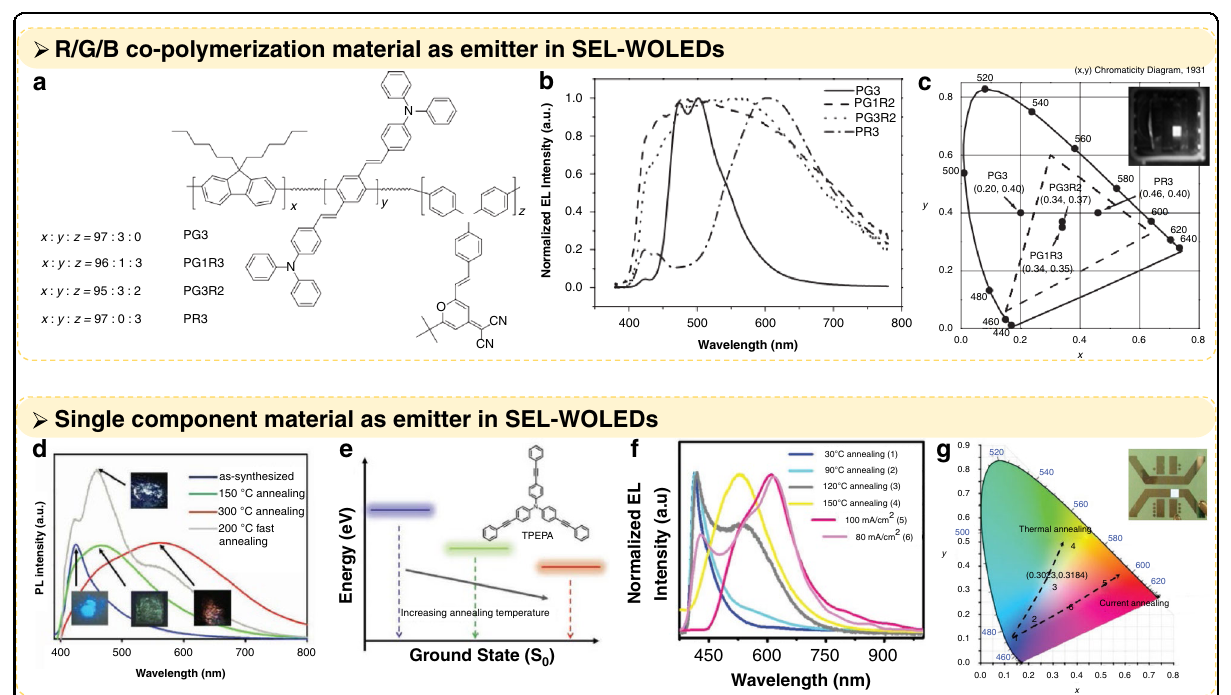
Fig. 6 Applying single substance emitters for SEL – WOLEDs. a Molecular structures of fl uorene-based copolymers. b EL spectra of the PG3, PG1R3, PG3R2, and PR3 devices with ITO/PEDOT:PSS/polymer/Ca/Al con fi gurations under 9 V. c CIE coordinates (x, y) of the PG3, PG1R3, PG3R2, and PR3 devices under 9 V (high-de fi nition, HDTV, dashed line). Reprinted with permission from ref. 48 . Copyright 2005 WILEY-VCH Verlag GmbH & Co. KGaA, Weinheim. d PL spectrum of synthesised TPEPA annealed at 150 °C and 300 °C and fast-annealed at 200 °C. The insets are images of these four powders under a 380-nm UV – LED source. e Schematic energy-band diagram of the PL spectrum with increasing annealing temperature. The inset is the molecular structure of TPEPA. f Normalised EL spectra of these six OLED devices. g CIE colour coordinates of these six OLED devices. The dashed line indicates that the possible colour region formed by this single organic material and the CIE coordinates of white OLED devices is (0.3023, 0.3184). Inset photo refers to the WOLED based on 120 °C annealing. Reprinted with permission from ref. 16 . Copyright 2019 WILEY-VCH Verlag GmbH &